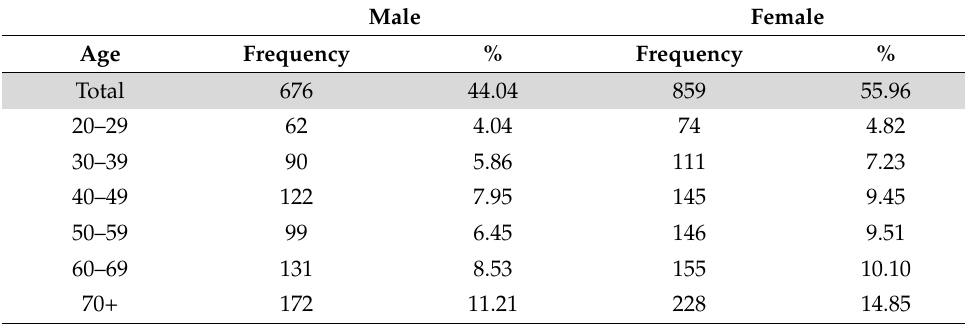
Table 1. Summary of the survey participants in the sample ( n = 1535).